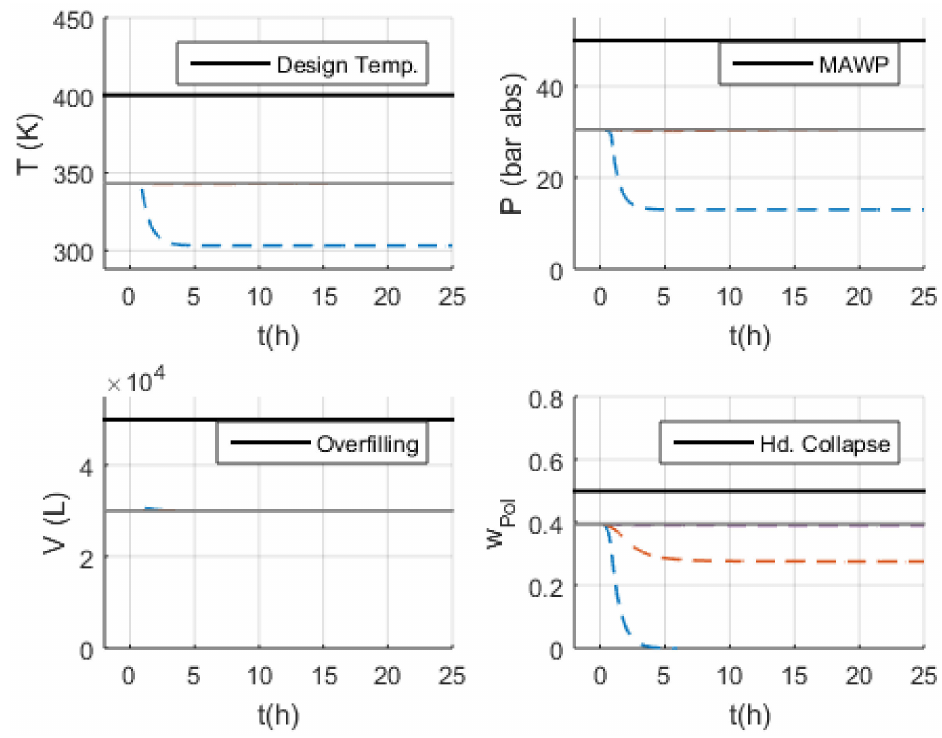
Figure 19. Behavior of critical variables in scenarios S-10 and S-11 with Model 1. Inlet PEEB mass flowrate: ( ) no flow; ( ) 50% of normal flow; ( ) 90% of normal flow; ( ) 99% of normal flow; ( )